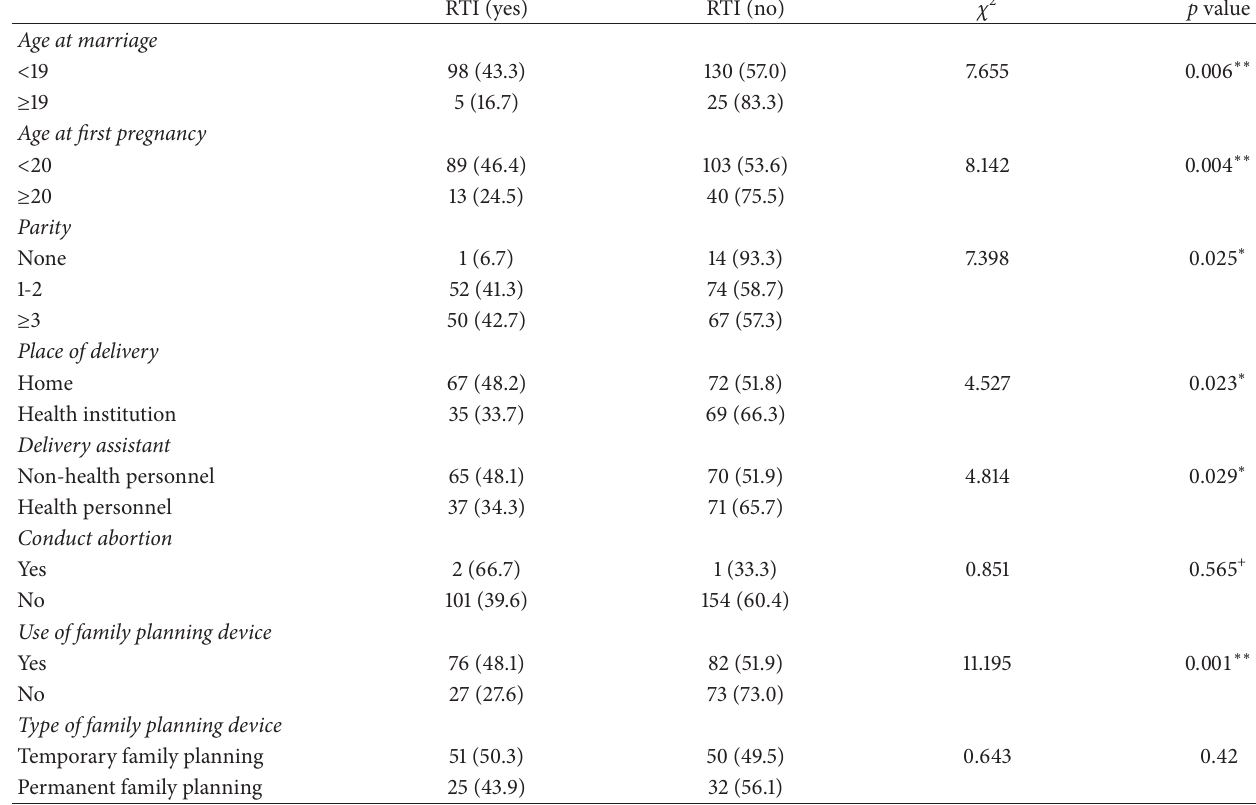
Figure in parenthesis indicates percentage, ∗ statistically significant at 𝑝 < 0.05 , ∗∗ statistically highly significant at 𝑝 < 0.01 , + fisher exact test, temporary (condoms, depo, IUD,